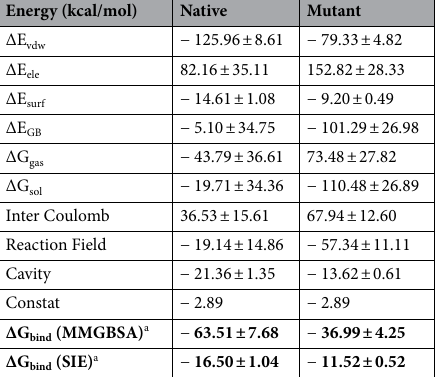
Table 2. Binding free energies for native and mutant systems using the SIE and MM-GBSA approach. a Computed according to Eqs. (2) and (3) (see “Methods” Section).